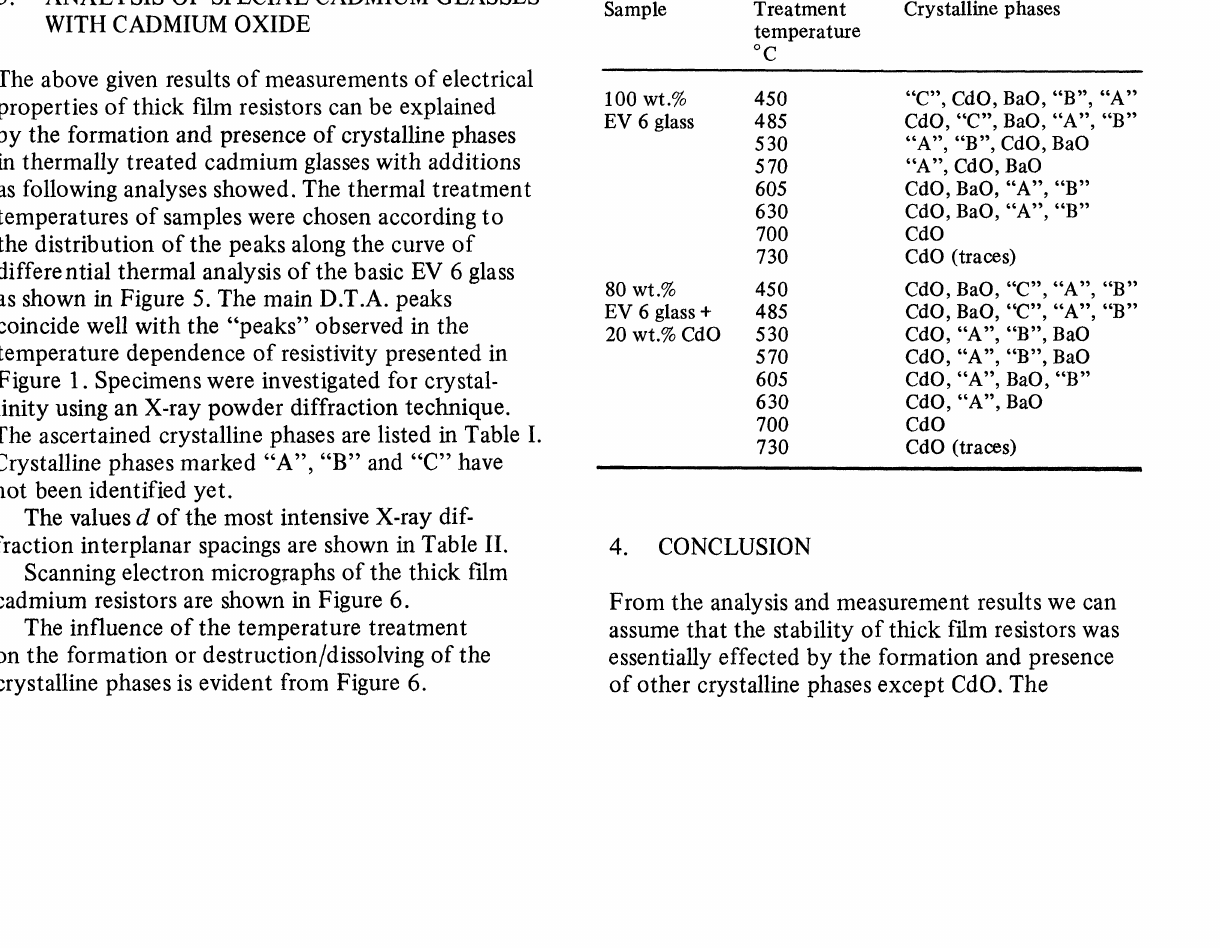
Differential thermal analysis of EV 6 glass.